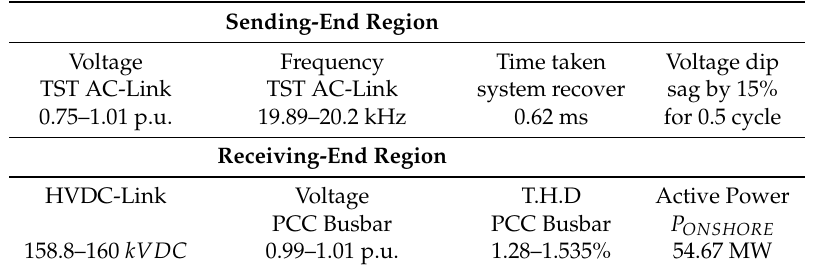
Table 6. Post-measurements collected at TST cluster-1 and PCC busbar (20 TST Units